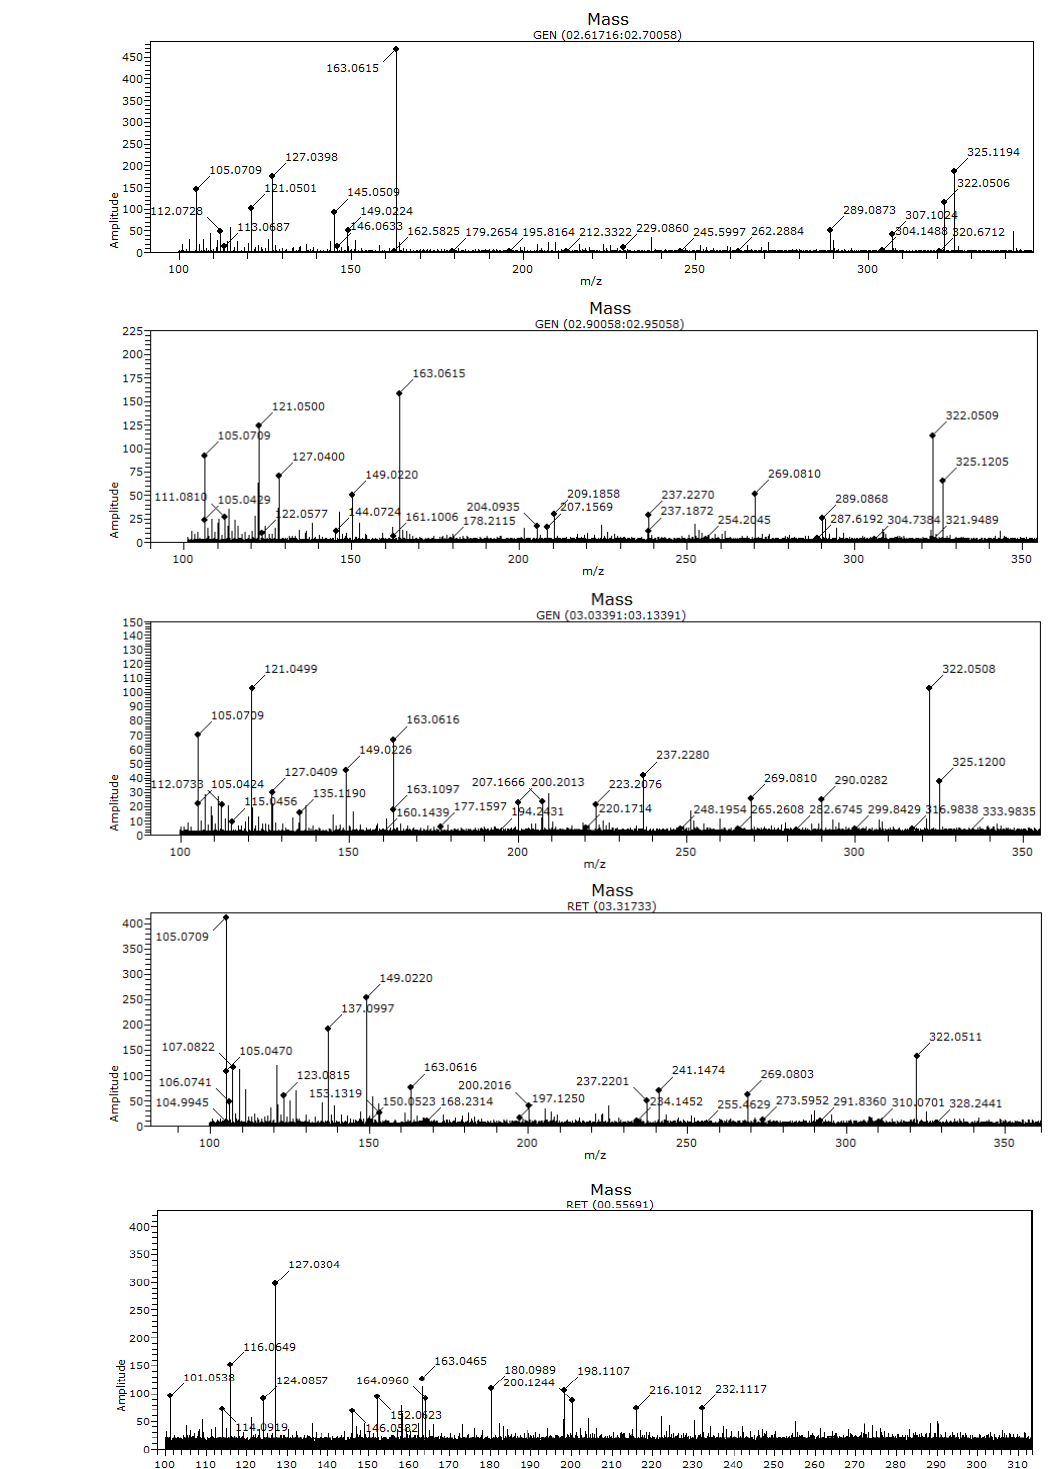
Figure 4. Spectroscopic profiles for phenolic compounds in 14 honey samples ( A – N ) obtained from the Las Lagos Region (Chile, 40 ◦ 15 (cid:48) S to 44 ◦ 14 (cid:48) S), as well as in 1 sample ( Z ) obtained from the Araucan í a Region (Chile, 37 ◦ 35 (cid:48) S to 39 ◦ 37 (cid:48) S). In turn, honey sample Z was collected as a control from the Araucan í a Region (38 ◦ 45 (cid:48) S 72 ◦ 40 (cid:48) W), located approximately 310 km from the other sampled beehives. The obtained mass spectrometry signals for the control sample differed from honey samples